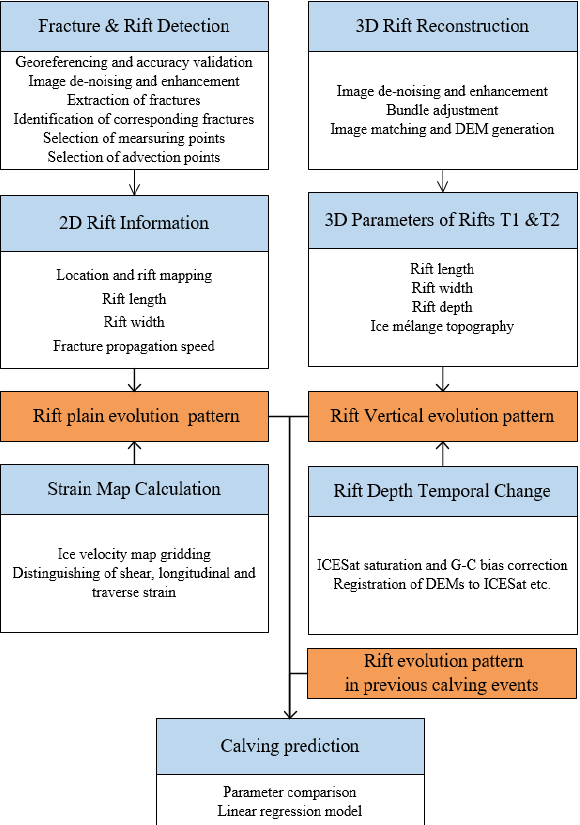
Figure 2. Framework of systematic fracture mapping